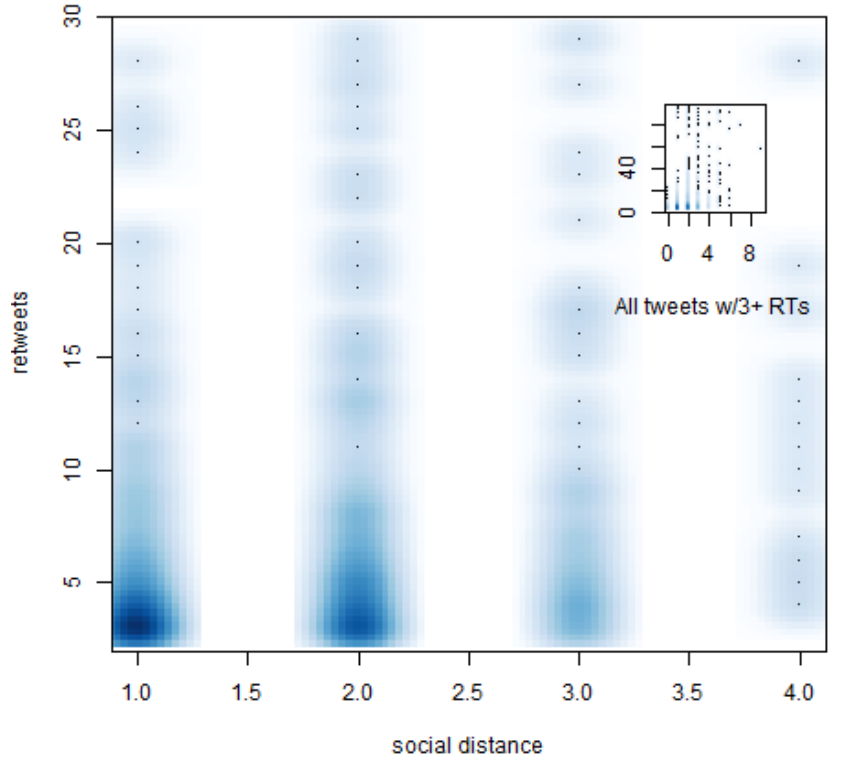
Figure 2. Density plot of social distance travelled by retweeted tweets by number of retweets (1-day sample).